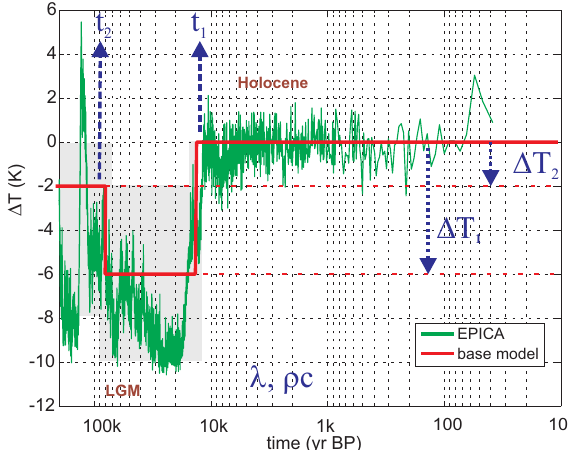
Fig. 1. GSTH forcing used for the calculations presented in this study. Also shown are the parameters and their variations used for the Monte Carlo investigations. 2 ˆ σ boundaries are marked by grey shades. The general shape of the GSTH for this numerical exper- iment is motivated by the EPICA ice core reconstructions (Jouzel et al., 2007). Note that the base model is constant since the post- glacial temperature